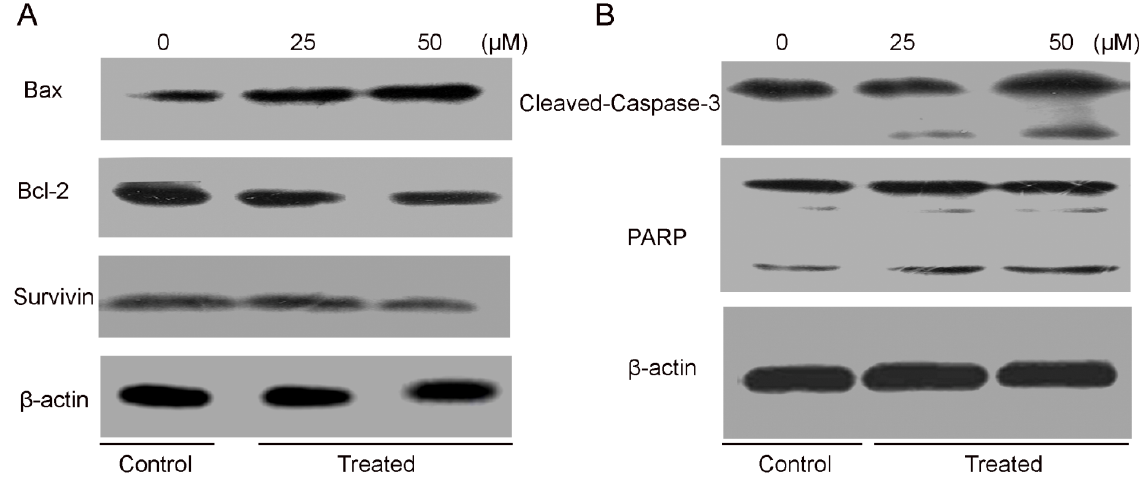
Figure 9. The effect of costunolide on the expression of major apoptosis regulatory proteins. T24 cells were exposed to 25 and 50 µM of costunolide for specified time intervals. Equal amounts of lysate protein were subjected to gel electrophoresis. ( A , B ) Expression levels of Bax, Bcl-2, survivin, caspase-3 and PARP were monitored by western blot assay. β -actin was used as loading control. Data are representative of three independent experiments with similar